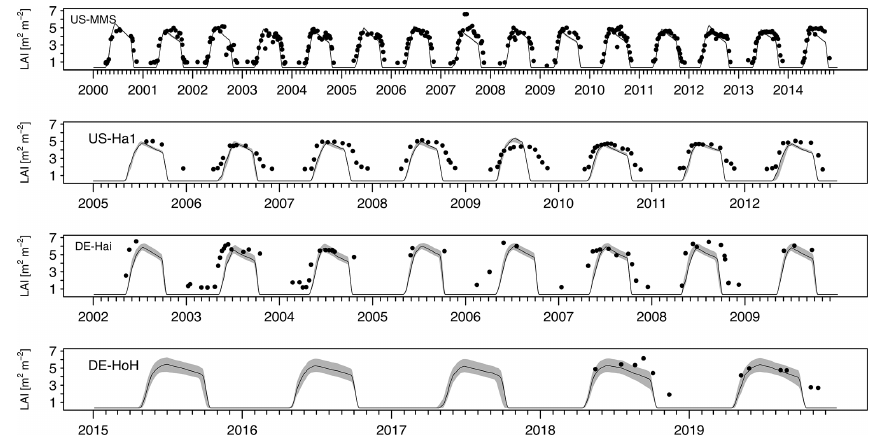
Figure 7. Time series of observed and simulated LAI at study flux tower sites during the common years of field measurements and simula- tions. The black dots indicate the field measurement LAI. The light gray, shaded area corresponds to ensemble members of the LAI output at each time step. The dark gray line refers to the median of ensemble